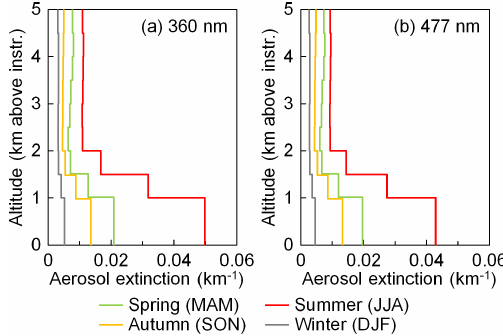
Figure 1. Seasonal average aerosol extinction profiles extracted from ceilometer